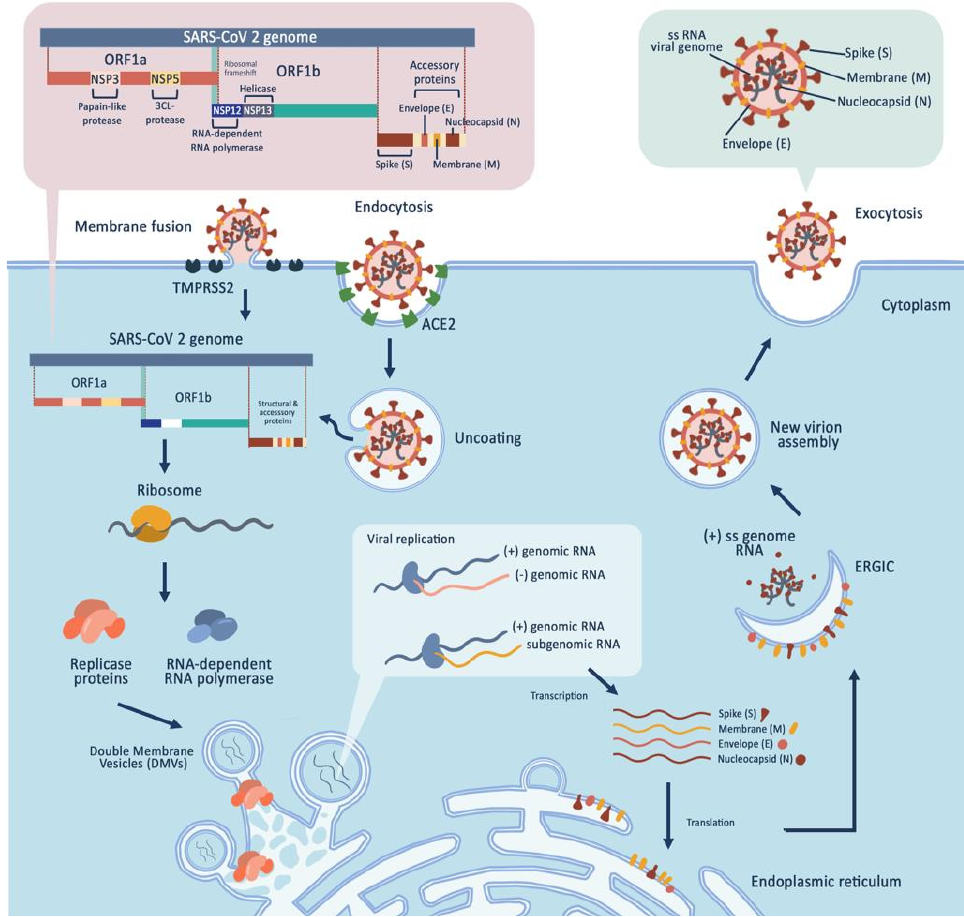
Figure 1. SARS-CoV-2 morphological features and life cycle.